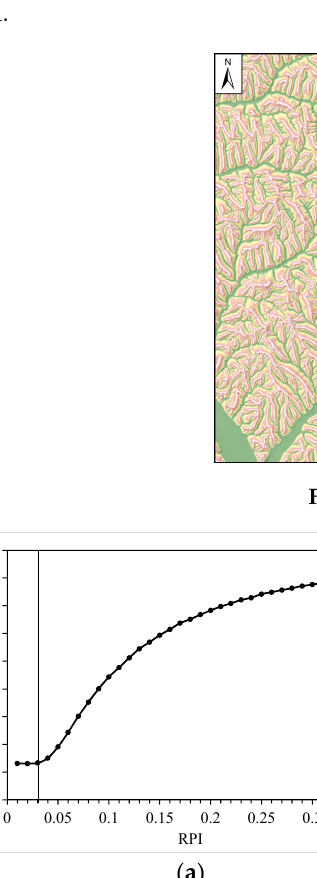
Figure 5. Relationship between the average slope and RPI: ( a ) lower-slope; ( b ) upper-slope.